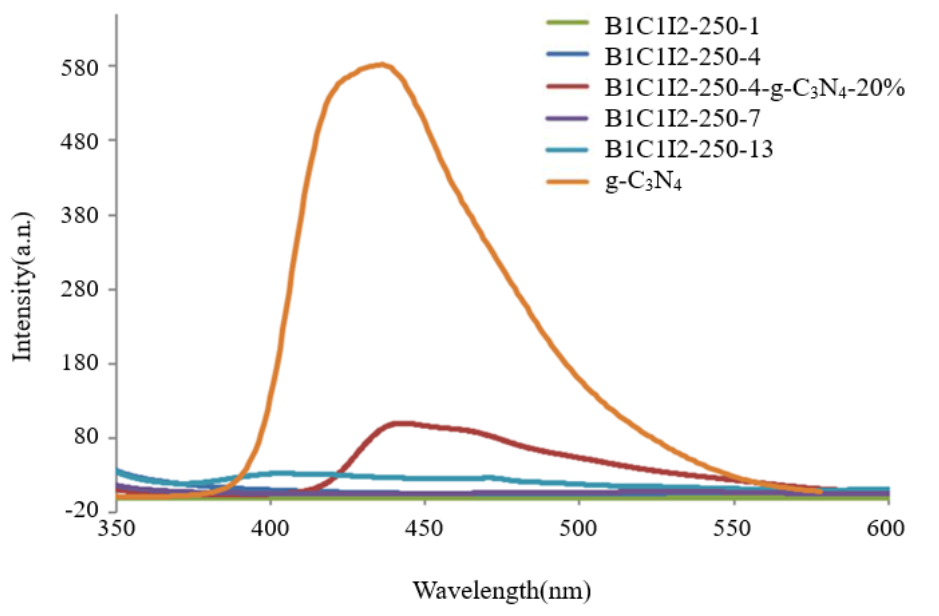
Figure 5. Photoluminescence spectra of the BiOmCln/BiOpIq/g-C3N4 − 20% photocatalyst prepared under a KCl:KI molar ratio of 1:2, a hydrothermal temperature of 250 ◦ C, and a pH of